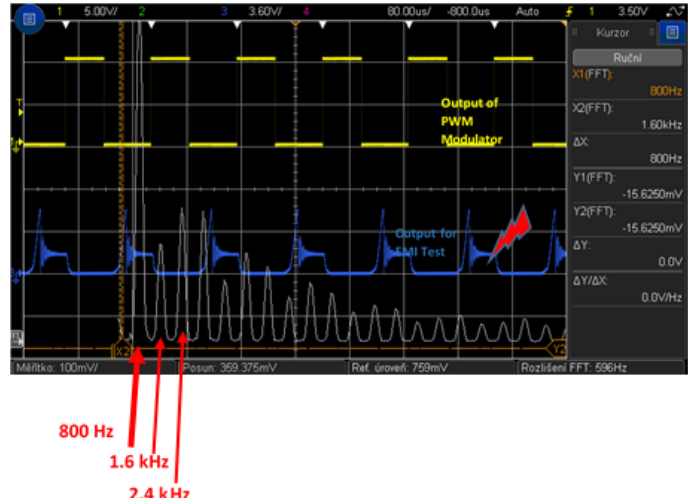
Figure 16. Generated interference signals.